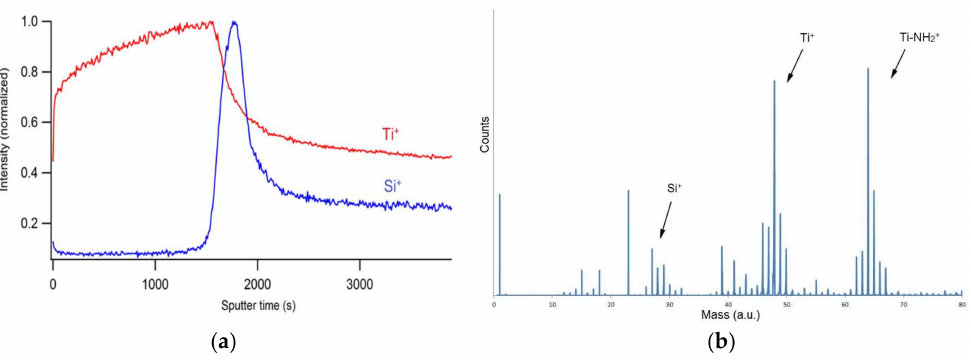
Figure 5. SIMS results from a sputtered TiO 2 -SiO 2 -PPSU sample ( a ) and its mass spectrum ( b